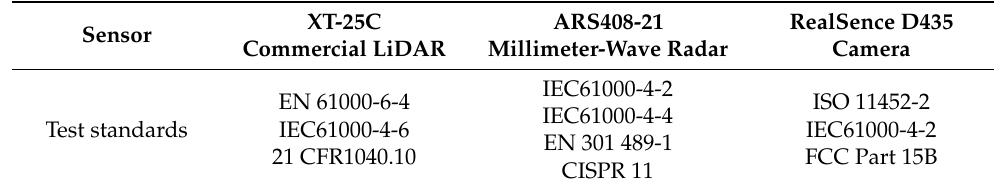
Table 1. Electromagnetic compatibility standards that the perception module hardware equipment has